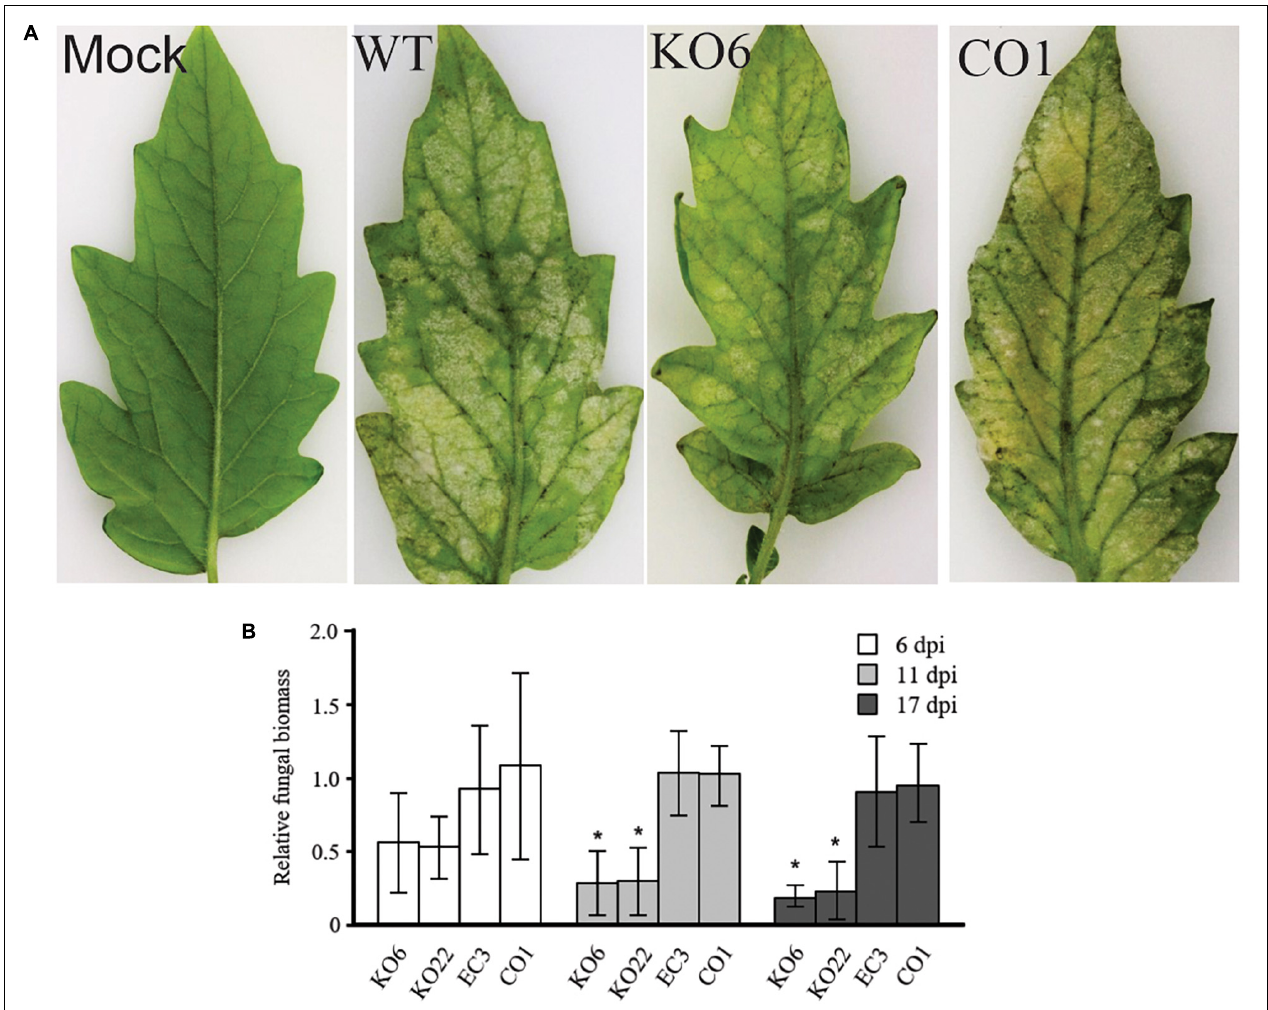
FIGURE 3 | Virulence assay of (cid:49) Ecp20-2 mutant strains of Cladosporium fulvum on tomato. (A) A representative picture showing MM-Cf-0 tomato plants 21 days after inoculation with wild-type strain 0WU; KO6, lacks a functional Ecp20-2 gene; EC3, ectopic transformant; CO1, KO6 complemented with the functional Ecp20-2 gene. A total of 15–20 leaves of three independent plants (three replications) were inoculated with conidia of C. fulvum . (B) Fungal biomass measurement by quantitative real-time PCR at 6-, 11-, and 17-days post-inoculation. The degree of fungal colonization was determined by the transcript levels of the constitutively expressed C. fulvum actin gene relative to the constitutively expressed tomato ribulose-1, 5-bisphosphate carboxylase/oxygenase (rubisco) gene in 100 ng of total genomic DNA from each sample. For each time point, fungal biomass was plotted relative to that of wild-type, which was set to 1.0. Bars represent mean values and standard deviation. The value of the column labeled with an asterisk differed significantly compared with those of the wild-type, EC3, and CO1 transformants ( P < 0.05, Tukey’s multiple comparison